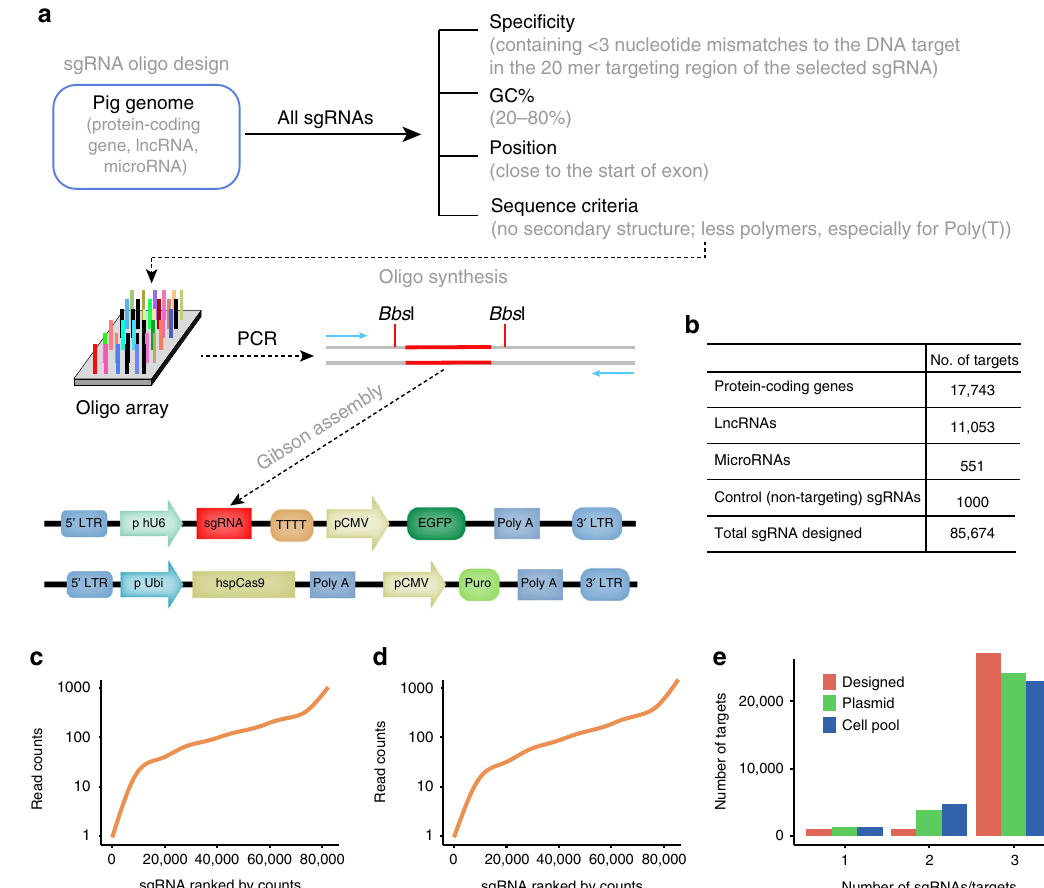
Fig. 1 Generation of a porcine genome-wide lentiviral sgRNA library. a Pipeline for sgRNA library design and construction. Protein-coding genes from Ensemble, lncRNAs from the domestic-animal lncRNA database (ALDB), and miRNAs from the miRBase database. Primers indicates by blue arrows were used for ampli fi cation of the sgRNA targeting sequences from the synthesized oligo array, which were cloned into the lentiviral plasmid. b The number of designed sgRNA targets. c , d Sequencing result of sgRNAs targeting sequences in two CRISPR pooled sgRNA libraries. Plasmid pools ( c ) and sorted mutant cell populations ( d ) containing the whole CRISPR pooled sgRNA library were characterized using next-generation sequencing (NGS). The curve indicates the distribution of sgRNAs. e The number of sgRNAs per gene in the genome-wide CRISPR pooled sgRNA library from the designed, plasmid, or mutant cell pools. sgRNA, small guide RNA; PCR, Polymerase chain reaction; hU6, human U6 promoter; Ubi, Ubiquitin promoter; CMV, Human cytomegalovirus promoter; EGFP, Enhanced green fl uorescent protein; TTTT, U6 terminator sequence; LTR, long terminal repeat; hspCas9, human codon-optimized Streptococcus pyogenes Cas9; Puro, puromycin; LncRNA, Long non-coding RNA; Designed, sgRNA designed by CRISPR-of fi nder software; Plasmid, the sequencing result of sgRNA library from plasmid pools; Cell pool, the sequencing result of sgRNA library from sorted mutant cell populations. Source